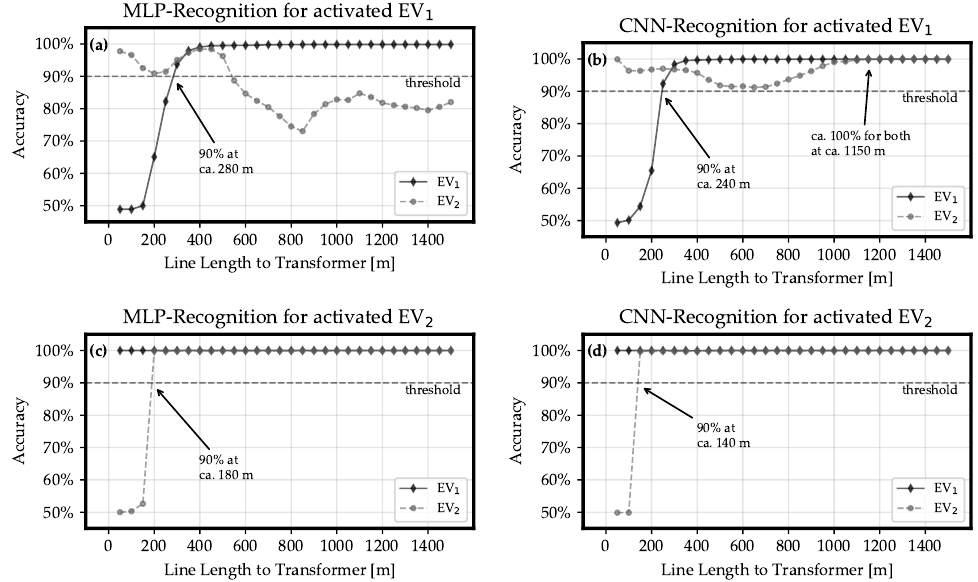
Figure 10. Relation between the line length from the measurement point/load to the transformer and the recognition accuracy using the best CNN and the best MLP found during the hyper-parameter optimization. Each panel shows the results of one neural network based on a scenario containing an activation of one electric vehicle (EV), while the other one was inactive. ( a ) MLP, data: active EV 1 and inactive EV 2 . ( b ) CNN, data: active EV 1 and inactive EV 2 . ( c ) MLP, data: inactive EV 1 and active EV 2 . ( d ) CNN, data: inactive EV 1 and active EV 2